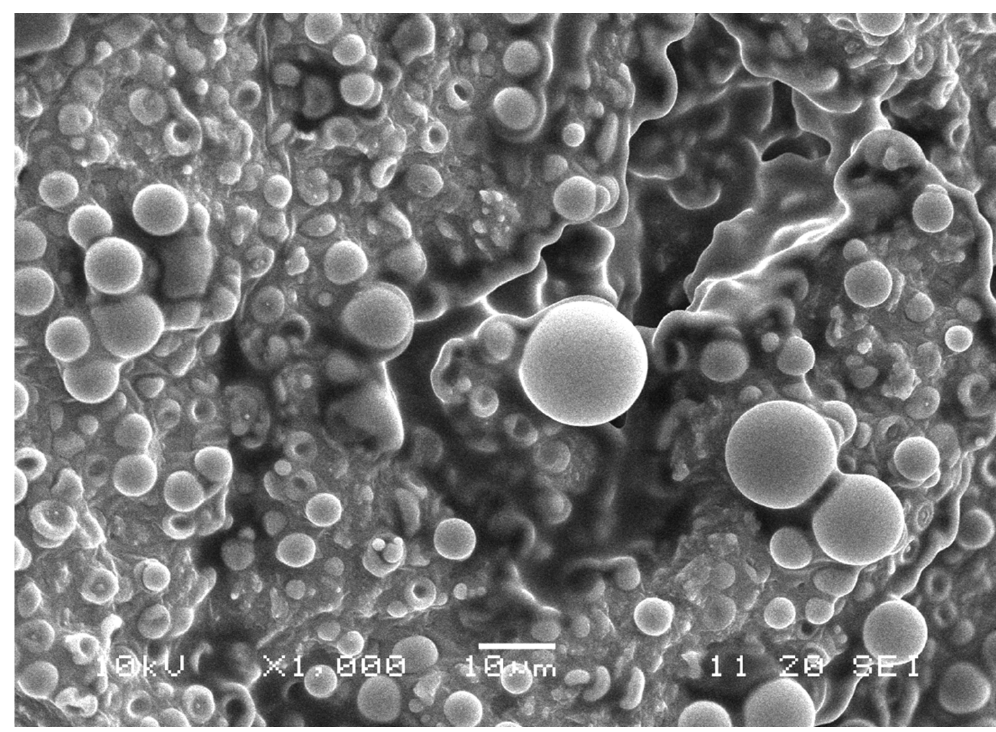
Figure 3. Preparation of rat aorta. PLA-DH microspheres on the surface of the vascular wall. Scanning electron microscopy image (SEM, Jeol 5500LV, Akishima, Japan), 1000× magnification.